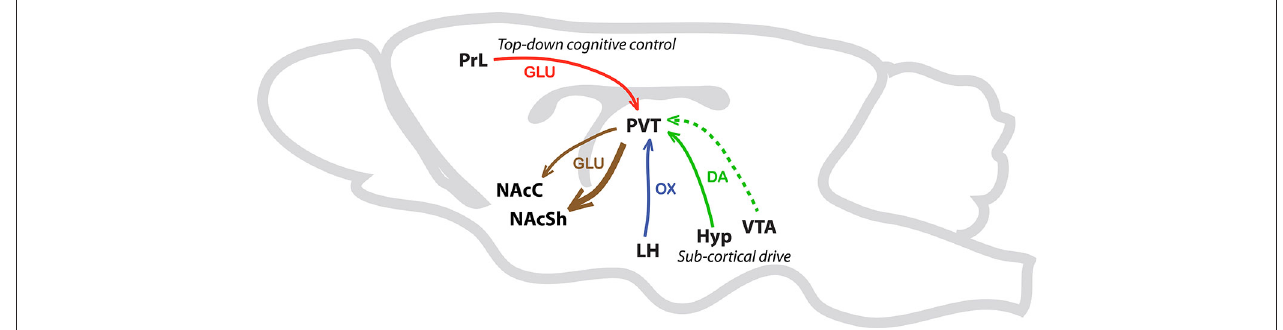
area (VTA). The blue arrow represents orexin (OX) input from the lateral hypothalamus (LH) and the red arrow represents glutamatergic (GLU) projections from the prelimbic cortex (PrL) to the PVT. Efferent pathways from the PVT to the nucleus accumbens shell (NAcSh), and to a lesser extent the nucleus accumbens core (NAcC), are represented with brown